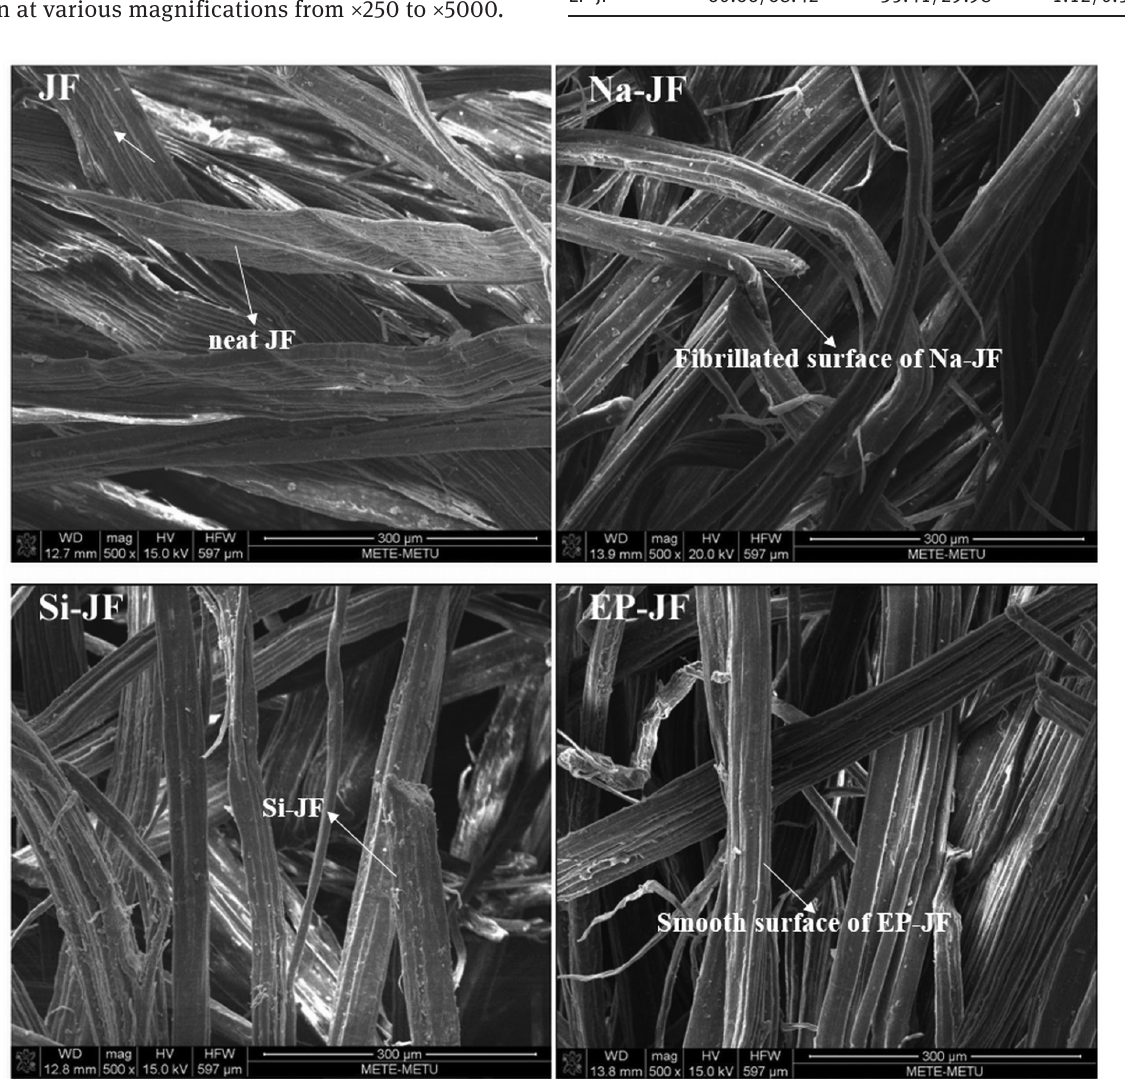
Figure 1: SEM images of JF samples.